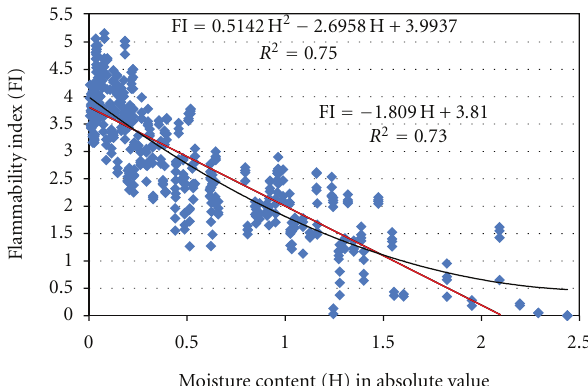
Figure 4: Flammability index (FI) values of Moroccan species as a function of their moisture content